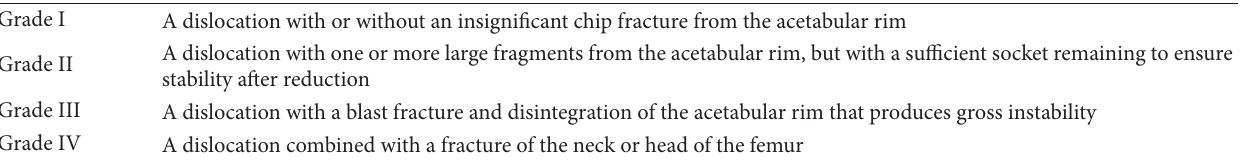
Table 1: Classification of traumatic dislocation of the hip [4].